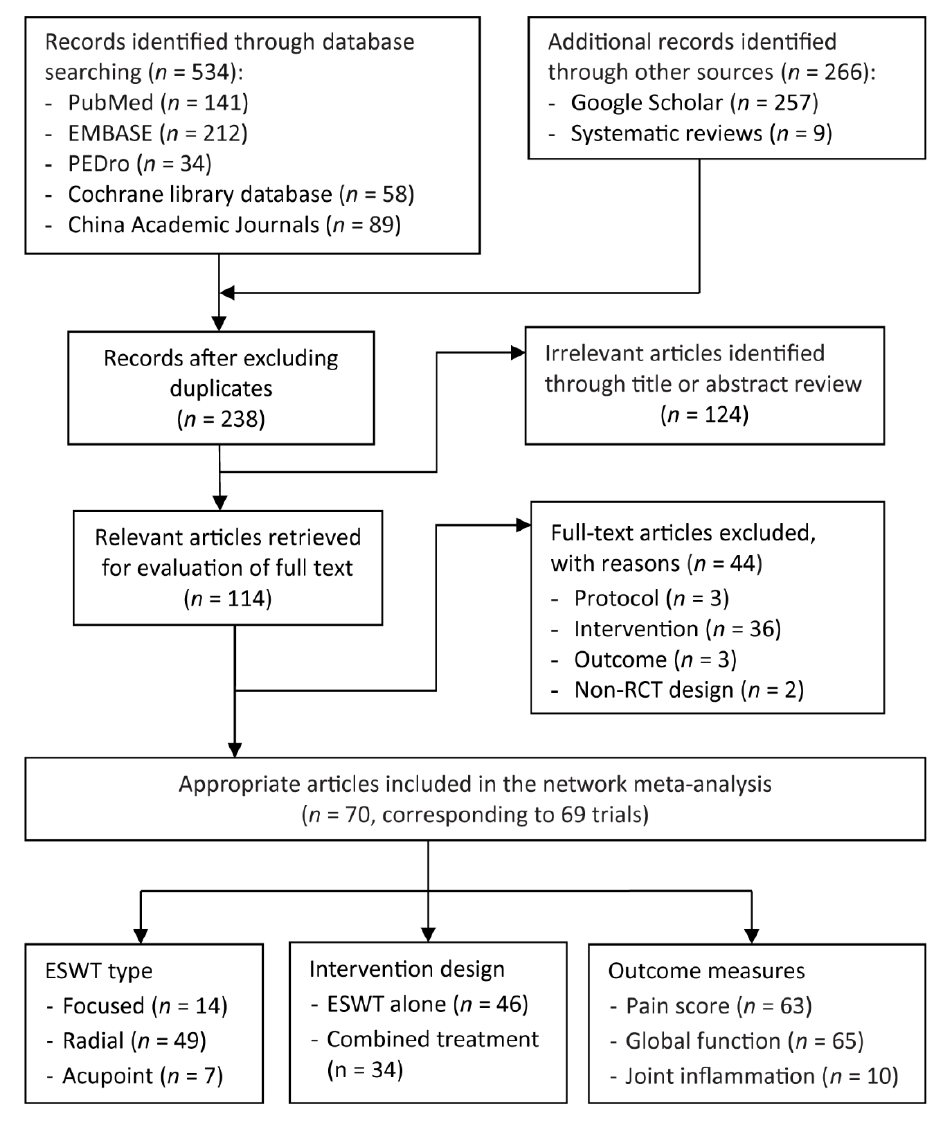
Figure 1. PRISMA flowchart of the study selection. ESWT, extracorporeal shockwave therapy; RCT, randomized control trial.